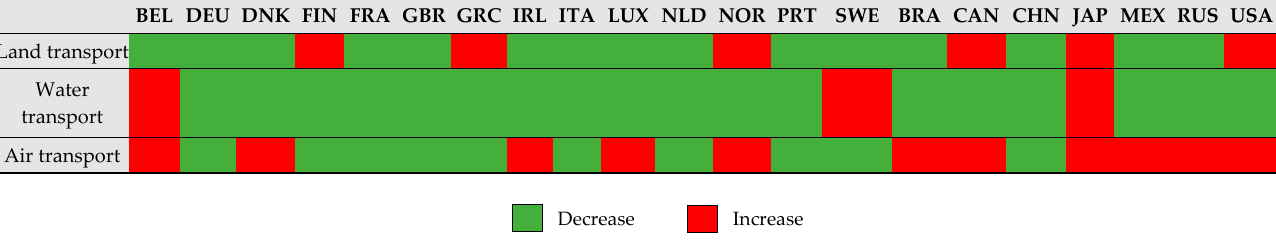
Table A1. Absolute variation in emissions per litre generated by Spanish DO wine exports (2005–2016). Source: Own preparation. * Non data available.